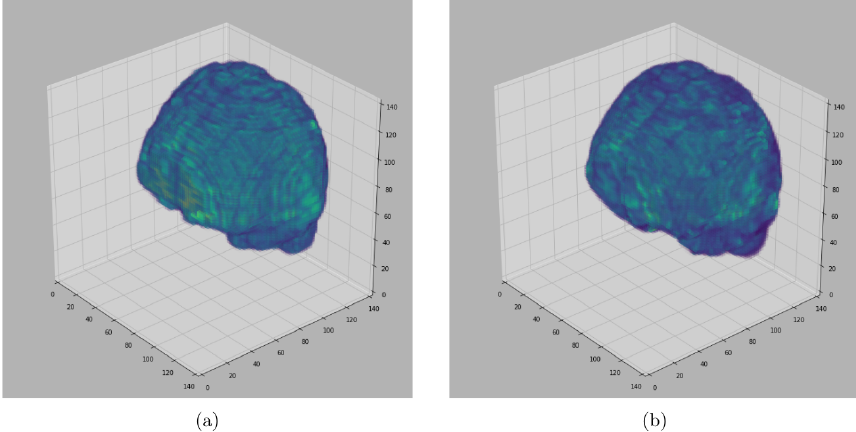
Figure 8. Segmented Brain (IBSR data): One representative subject representing ( a ) 3D brain seg- mented using GUBS approach (predicted), ( b ) 3D brain (ground truth). The ground truth was obtained by manual-guided expert